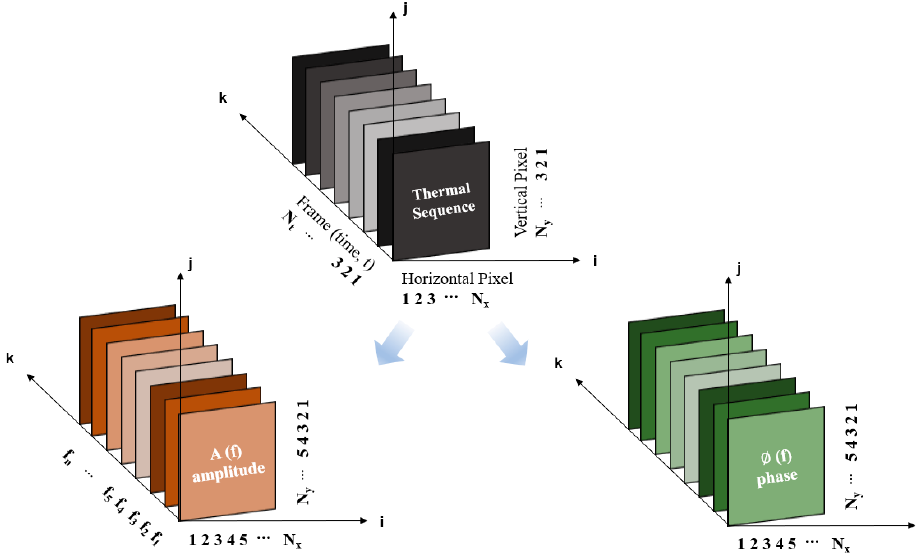
Figure 2. Principle of data acquisition and processing by fast Fourier transform.